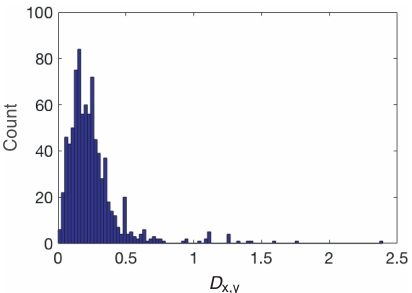
Figure 1. A histogram of the normalised distance to the nearest neighbour in GDGT space ( D x,yt ) for all samples in the modern calibration dataset of Tierney and Tingley (2015).